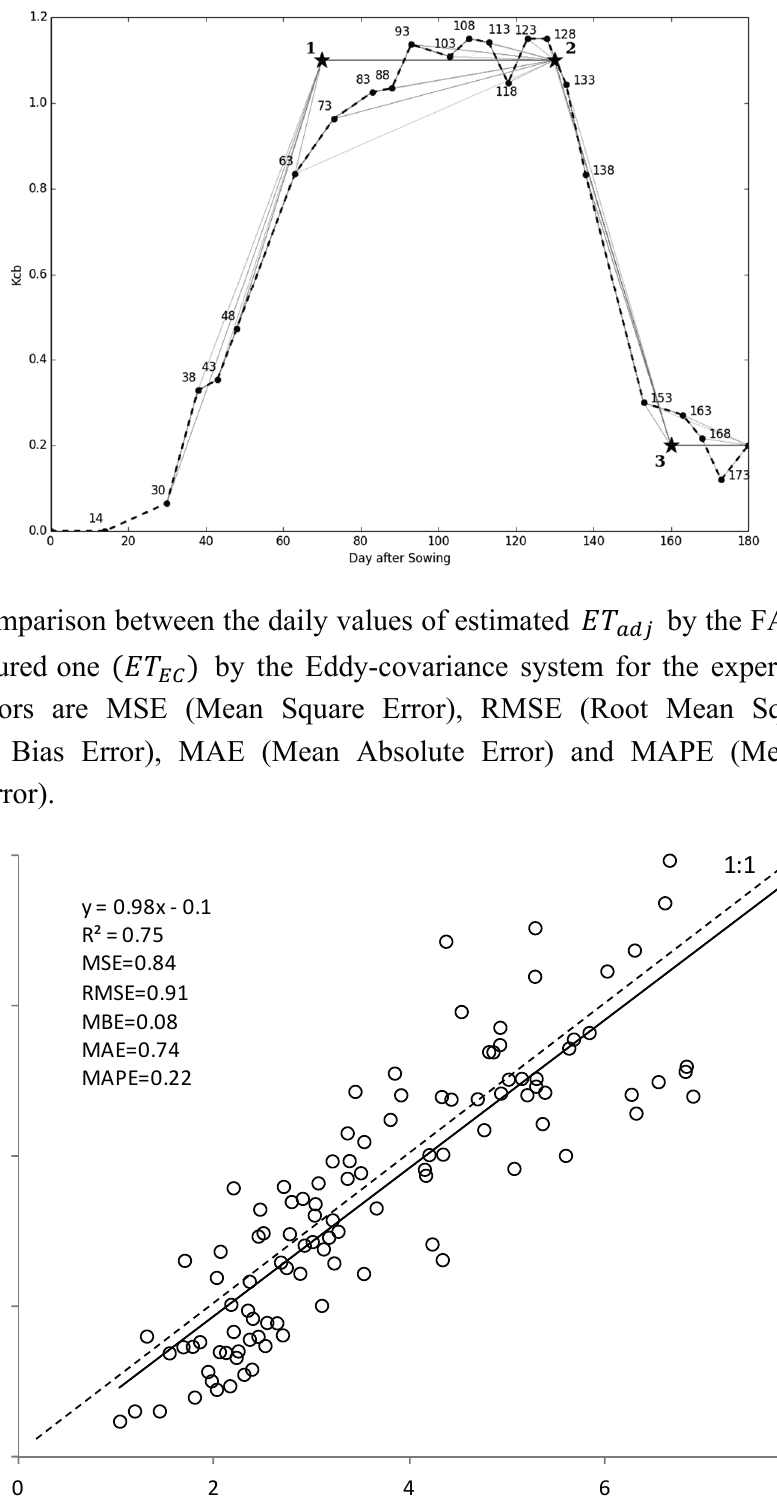
Figure 6. Kc b derived from NDVI (dashed line) and evolution of extrapolations as new images are arriving (dark to light gray) for the experimental plot. Each time a new image is received (dot and DaS small label), the Kc b trajectory is corrected. The three inflexion points extracted from the FAO-56 tables are indicated by a star and a bold label.